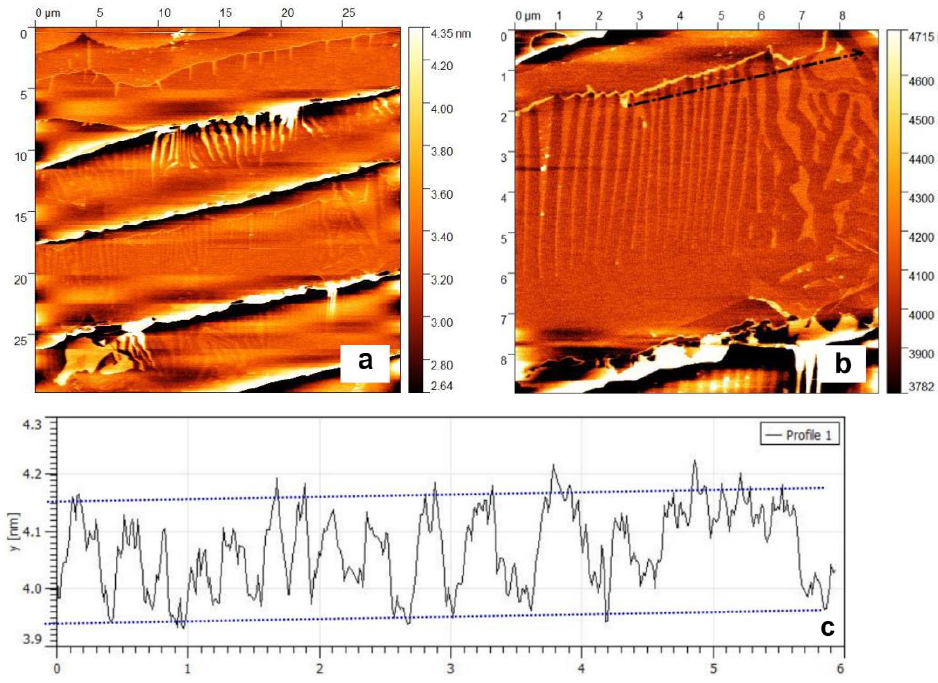
Figure 2. ( a ) 30 × 30 µ m 2 of the graphitized surface of sample StGr-6. Bigger, parallel steps of about 4.5 nm in height are visible, running approximately from left to right in the picture. On the terraces between the steps, slightly brighter, slim fingers grow in the direction of the next step that is oriented higher than the point they originate from; ( b ) 9 × 9 µm 2 close-up of these bright fingers. The dashed black arrow indicates the trace of the height-profile depicted at the bottom Figure 2c; ( c ) 6 µ m long profile across the surface of a terrace where a characteristic growth front of a sample grown on the Si-polar face of SiC. Dashed blue lines indicate the minimal height detected of the growth front; and the approximate mean of the valleys in between them respectively. Often, the surface showed a sub-hexagonal network of bright lines that are slightly elevated relative to all other features (Figure 3a). These lines span the whole surface and run over both small steps and bunched steps alike. Typical heights of the lines relative to the structure beneath them were measured to range between 0.5 and 1.3 nm. In some in- stances, the hexagons are replaced by pentagons or heptagons, displaying the presence of defects. Usually, networks of very pronounced hexagonal shapes showed a second, very faint network beneath them (Figure 3b). The bottom network is oriented like the more pronounced one, however is an independent structure. The maximum step-heights of the underlying network were determined to be typically between 1.5 and 3 Ǻ (small peaks in Figure 3c) and are thus difficult to measure and may represent one layer of graphene.